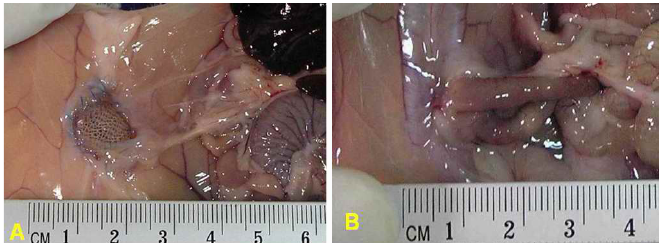
FIGURE 2 - Macroscopic evaluation of abdominal adhesion in rats after polypropylene mesh and polypropylene mesh coated with polyHEMA; ( A ) Omentum adhesion to the suture zone (Group PH); ( B ) Intestinal adhesion to the mesh surface (Group PP)